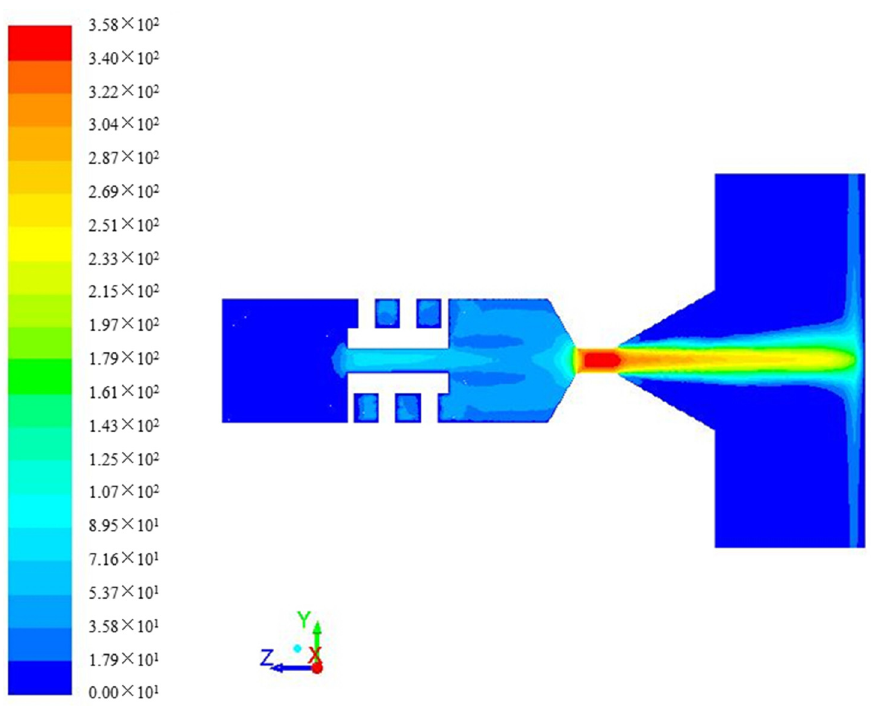
1 Figure 3. The velocity contour of swirling-round SC-CO 2 jet flow